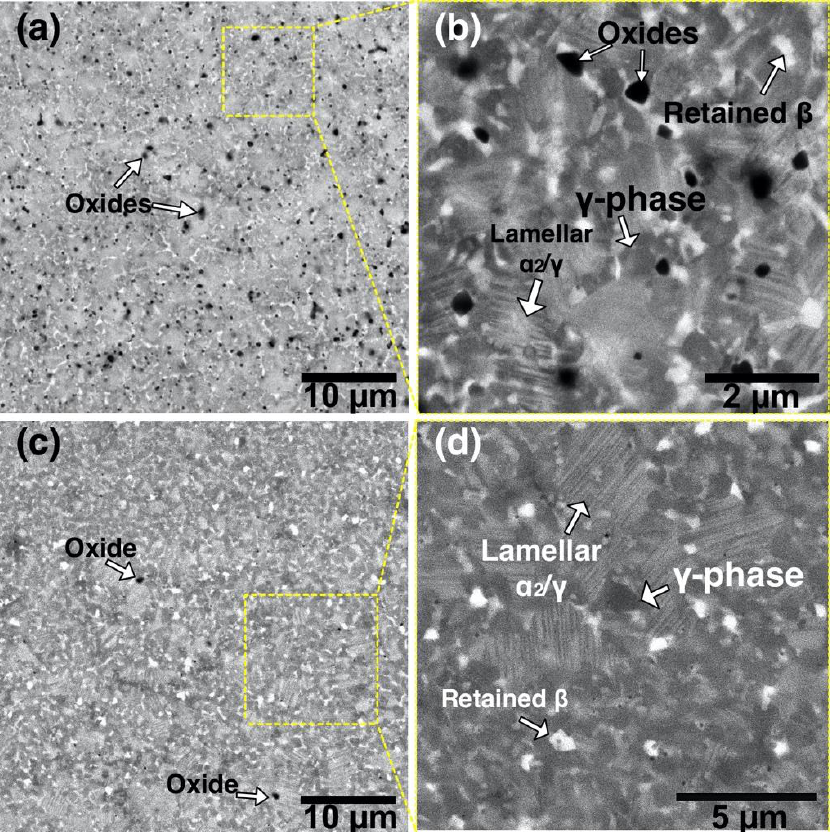
Figure 8. BSE-SEM images showing microstructures of the samples fabricated from the MAPS powder at ( a , b ) 800 °C (sample 2_800) and ( c , d ) 900 °C preheating temperature (sample 2_900).